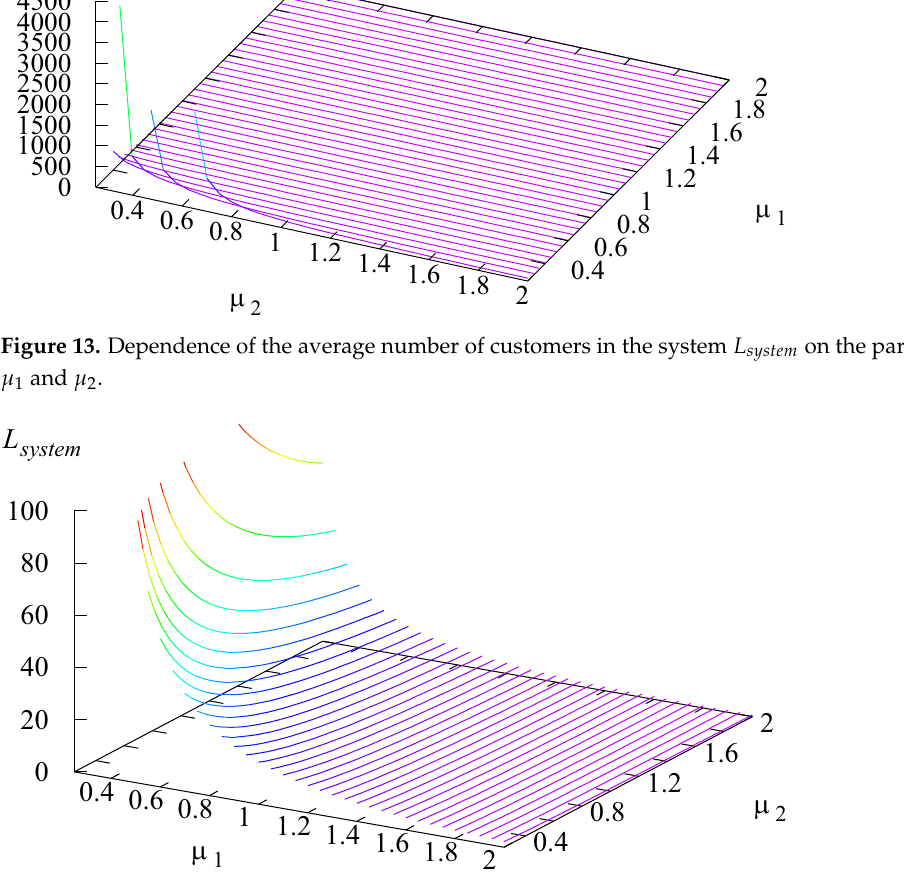
Figure 14. Dependence of the average number of customers in the system L system on the parameters µ 1 and µ 2